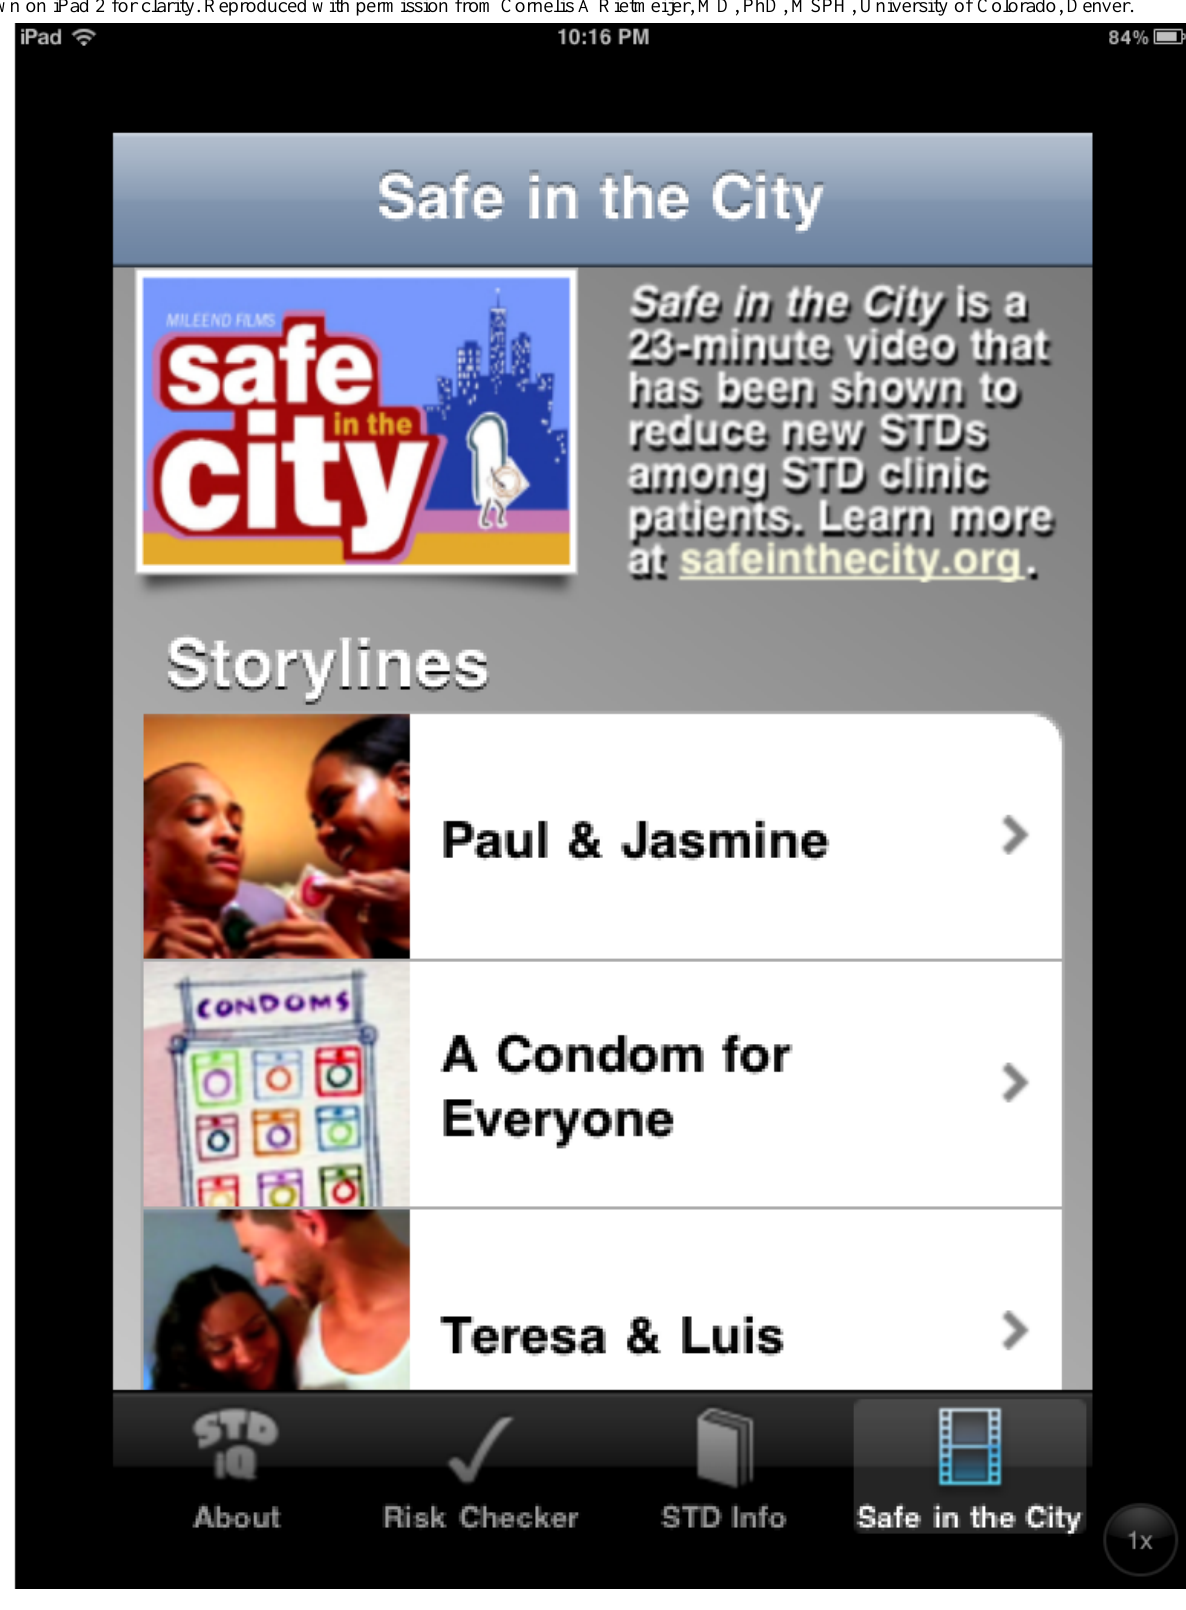
Figure 6. Screenshot of STDiQ app featuring racially/ethnically diverse videos from the Safe in the City STD reduction intervention. iPhone version shown on iPad 2 for clarity. Reproduced with permission from Cornelis A Rietmeijer, MD, PhD, MSPH, University of Colorado,